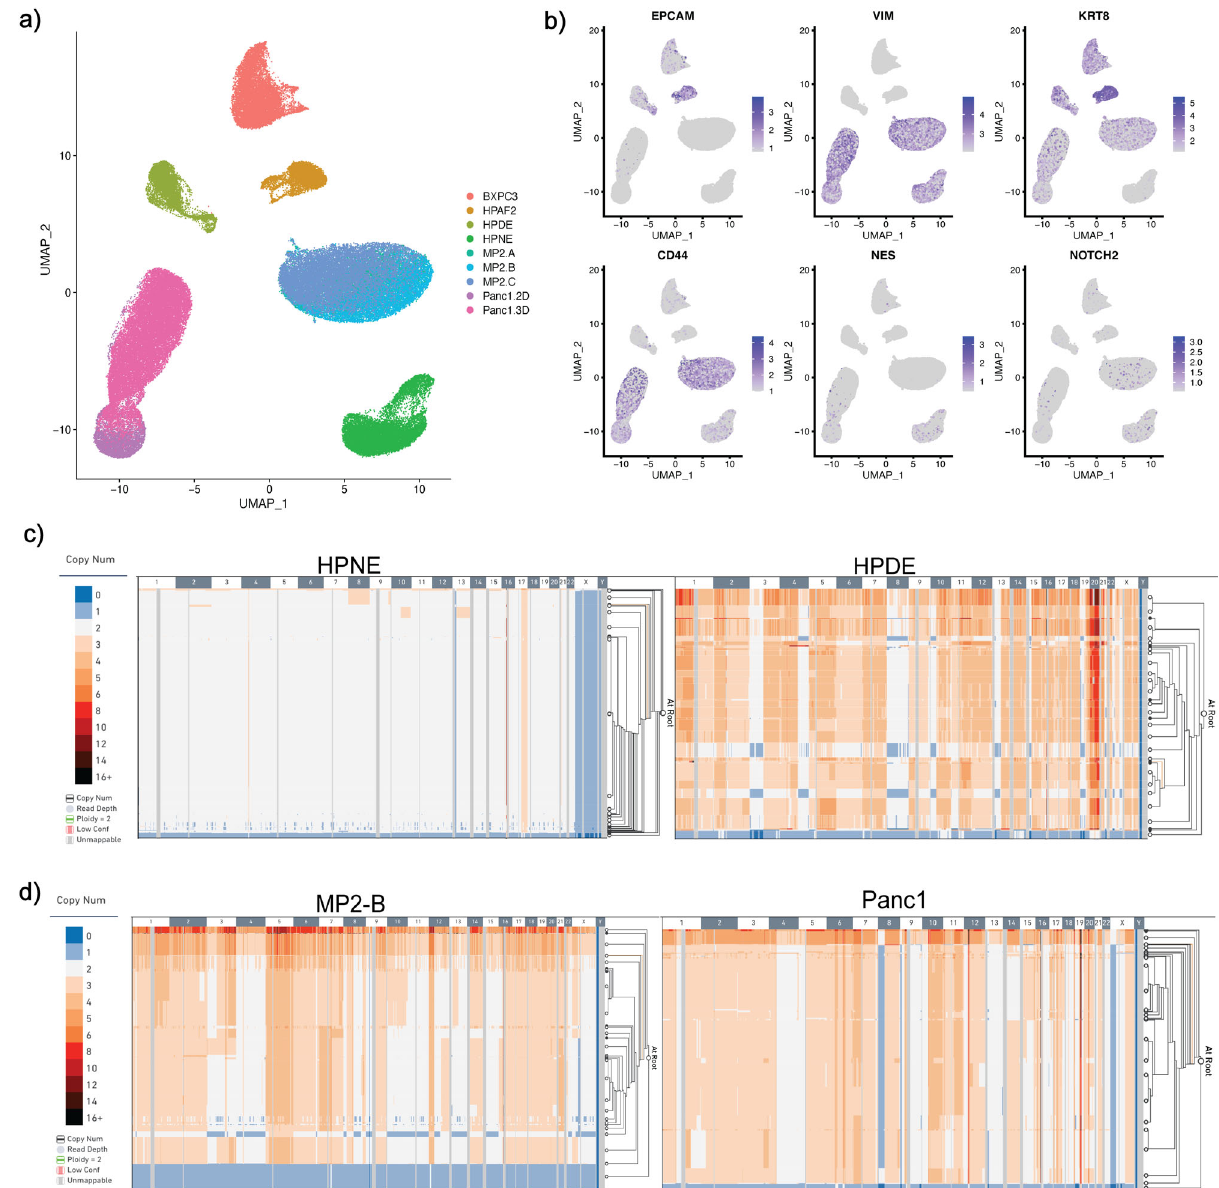
Fig. 1 PDAC Cell Lines display heterogeneity at single-cell level. a Uniform manifold approximation projection (UMAP) plot of single cells from PDAC cell lines used in this study. b UMAP Feature Plotting for known cell-type markers (EPCAM, MUC1 for epithelial; vimentin, and KRT8 for mesenchymal cellular origin). c , d Representative scCNV plots for cell lines. Columns indicate chromosomes (numbers labeled in gray and white), rows indicate individual